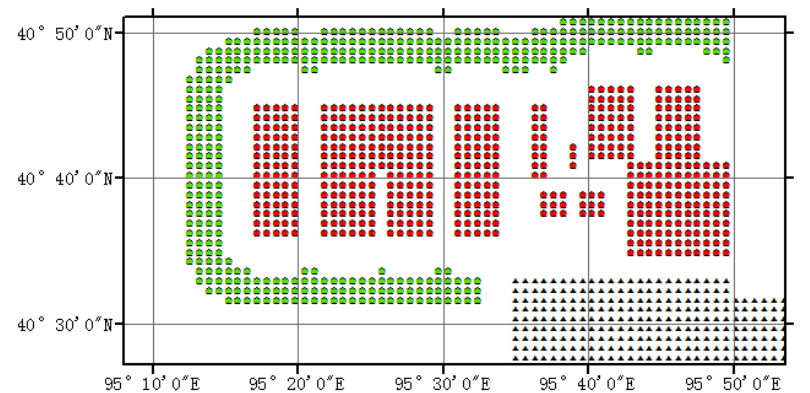
Figure 2. Wind farm pixels (WFM) in red dots, nearby non-wind-farm pixels (NNWF) in green dots and the center of Guazhou county pixels (GZ) in black triangles over the study area. The pixel resolution is 0.01°.